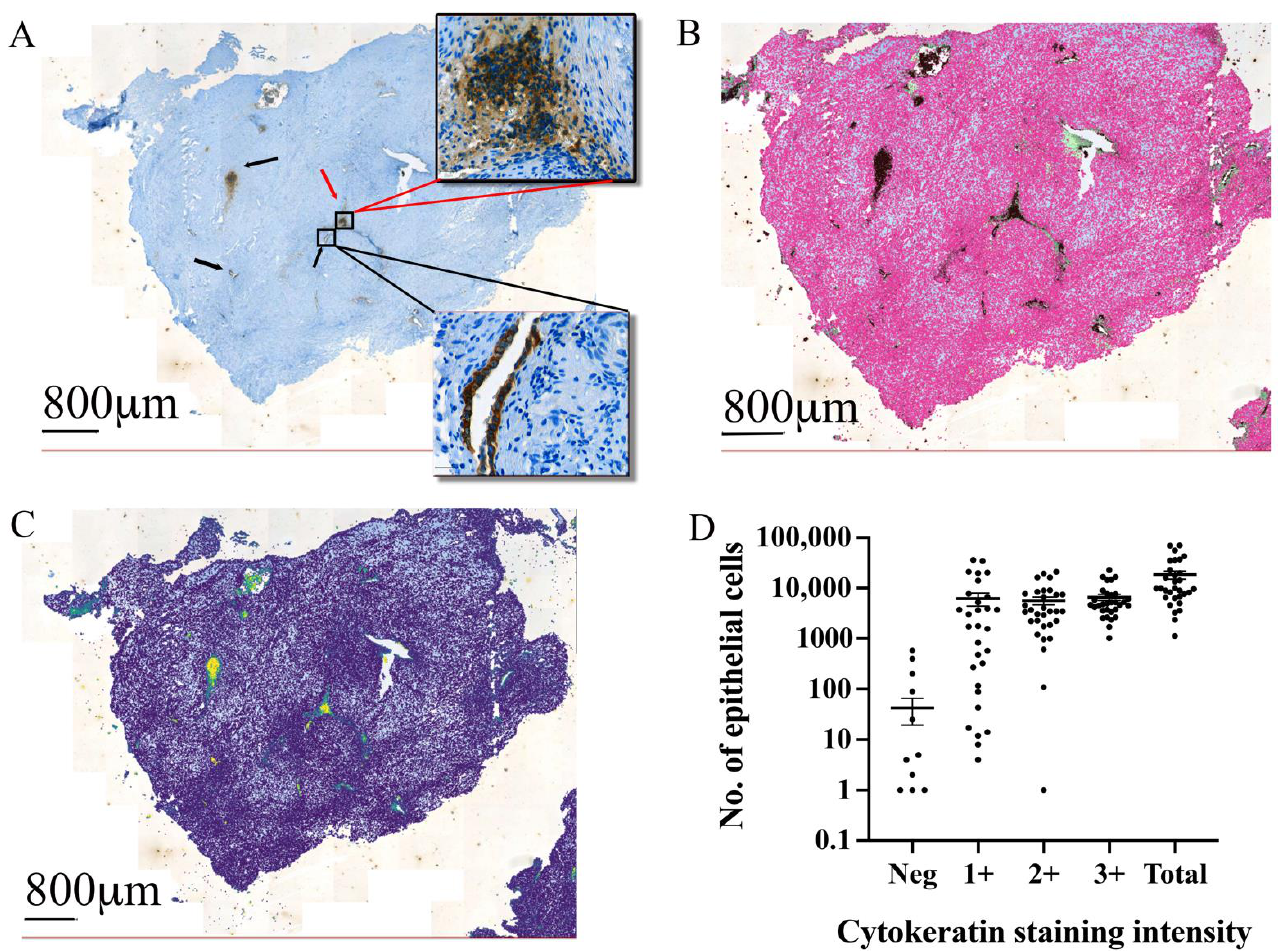
Figure 3. Cytokeratin and automated identification of epithelial cells in endometriotic lesions. ( A ) Mouse anti-cytokeratin antibody staining identified regions with characteristic glandular structures as epithelial cells (black arrows), and positive epithelial cells without the characteristic glandular structure (red arrows). ( B ) Automated cell detection using the object classifier quantified positive epithelial cells within the excised tissue. ( C ) Pixel smoothing provides the options to observe the extent of the epithelial compartment in the endometriotic lesions. ( D ) The automated counting of epithelial cells showed similar numbers of light (1+), moderate (2+), and heavily stained (3+) epithelial cells in all samples. Only a minimal number of automatically detected epithelial cells were negative for cytokeratin expression.